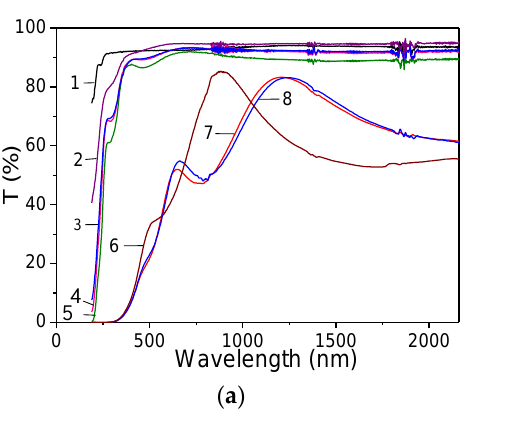
Figure 11. ( a ) Transmission spectra for a quartz substrate (1), for PECVD films of 210–250 nm thickness obtained at T dep = 373 (2), 423 (3), 473 (4), and 523 K (5); and for LPCVD films of 230–250 nm thickness obtained at T dep = 673 (6), 873 (7), and 973 K (8). ( b ) Temperature dependencies of optical band gap for the PECVD and LPCVD films. Black rhombs and red circles—spectrophotometric data. Red asterisks—spectral ellipsometry data.